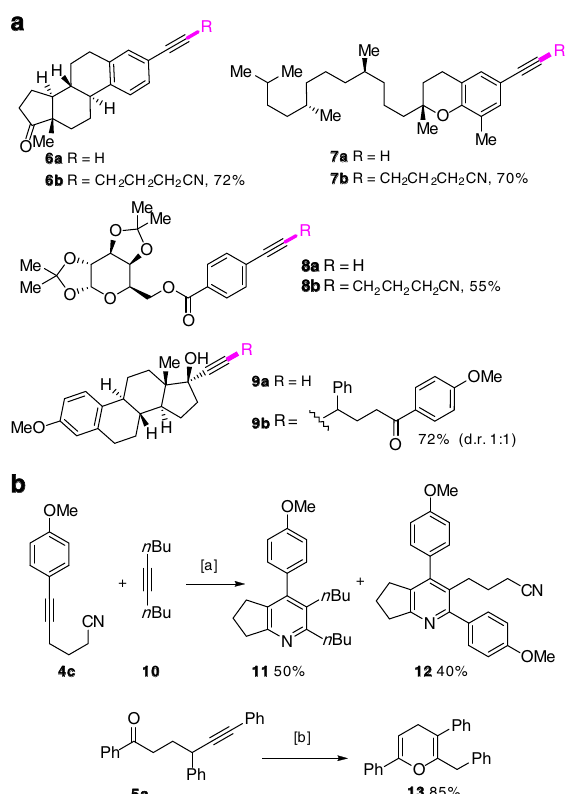
Fig. 5 Synthetic application. a Functionalization of natural products, b post- functionalization of γ -alkynyl nitrile and γ -alkynyl ketone. [a] Ni(COD) 2 (5 mol%), PBu 3 (10 mol%), BPh 3 (20 mol%), toluene, 50 °C, 24 h. [b] t BuOK, THF, 0 °C.